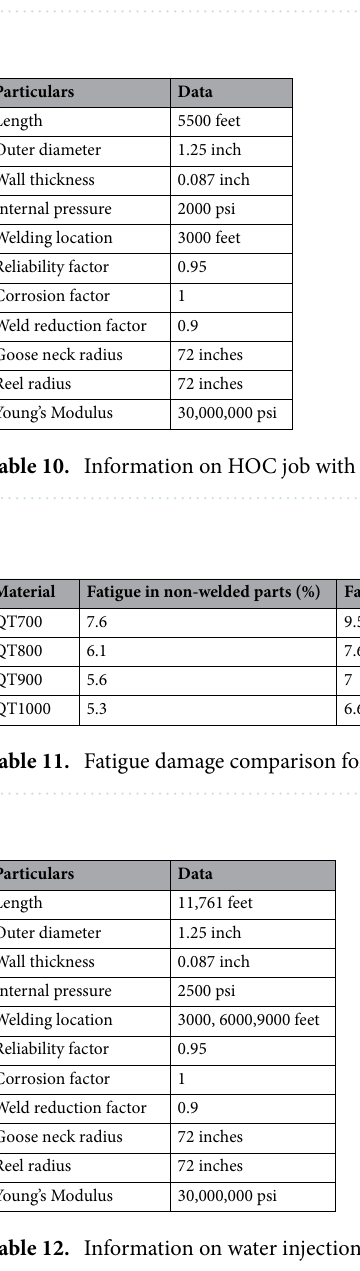
Table 9. Comparison of fatigue damage for different CT material.